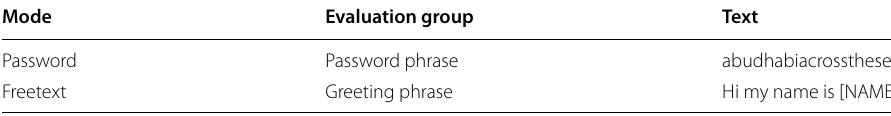
Table 7 Text configuration for attack spoofing